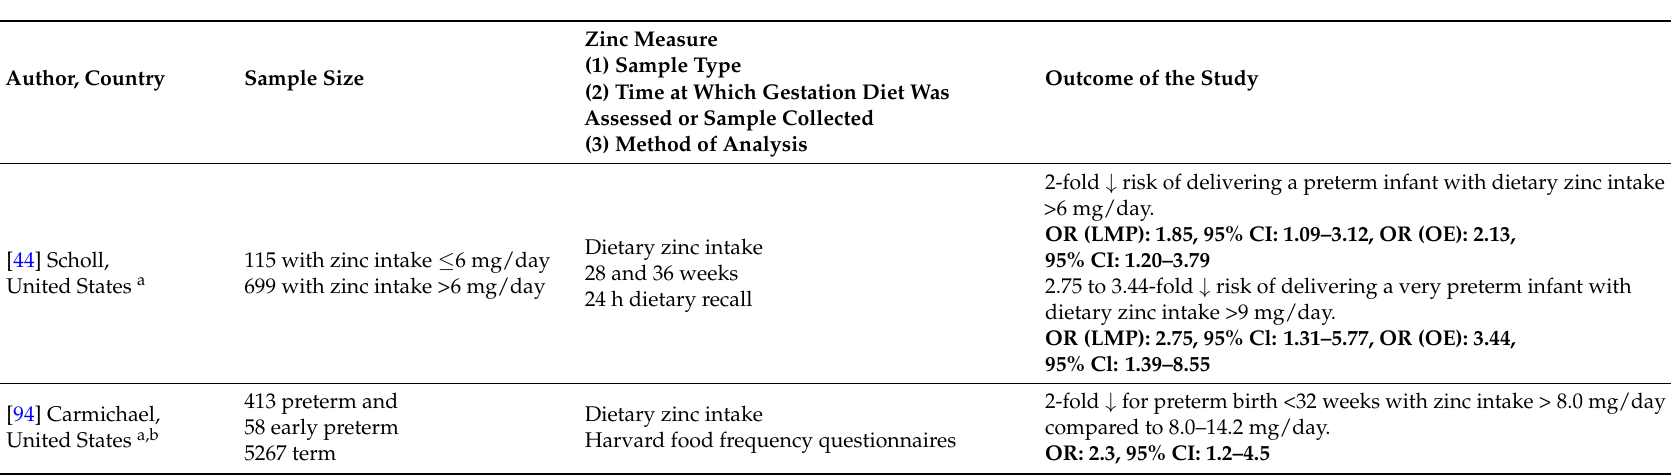
Table 3. Included studies assessing maternal zinc status and